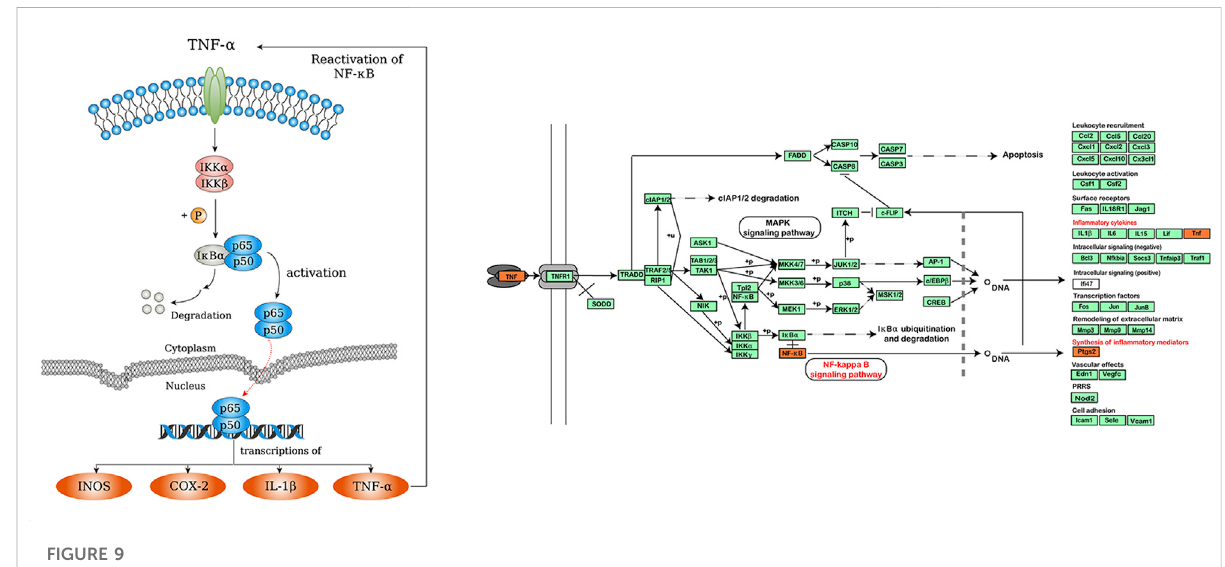
FIGURE 9 NF- κ B and TNF signaling